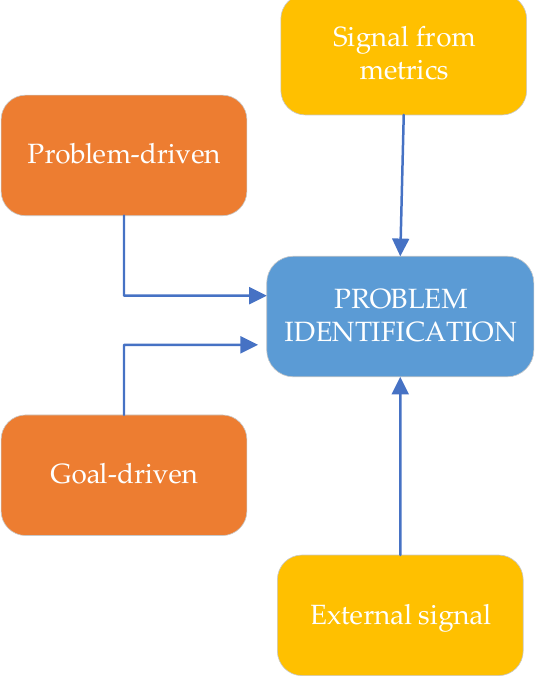
Figure 3. Triggers for the process (source: Biresselioglu et al. [28]).